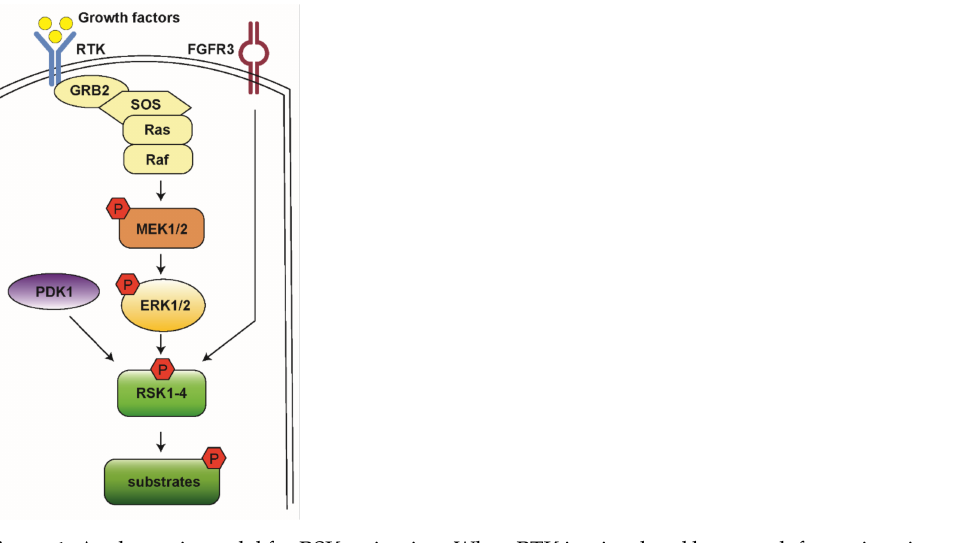
Figure 1. A schematic model for RSK activation. When RTK is stimulated by growth factor, it activates the docking proteins GRB2 and SOS. SOS triggers Ras to exchange guanosine diphosphate (GDP) to guanosine triphosphate (GTP) and then to become activated. Ras activates Raf kinases, which phosphorylate MEK1/2, ERK1/2, and RSK1-4. Then, RSKs phosphorylate various downstream substrates to mediate diverse cellular processes.